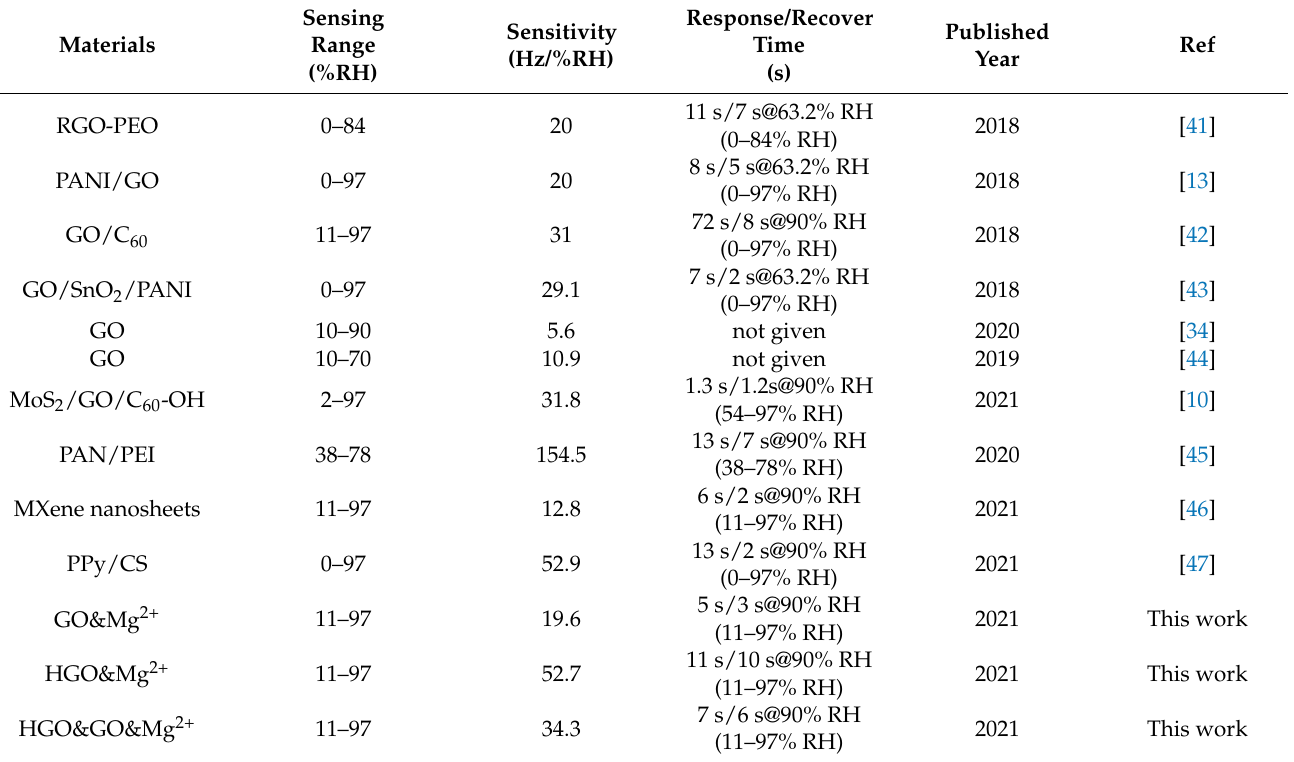
Table 1. Comparison between recently reported QCM humidity sensors and this